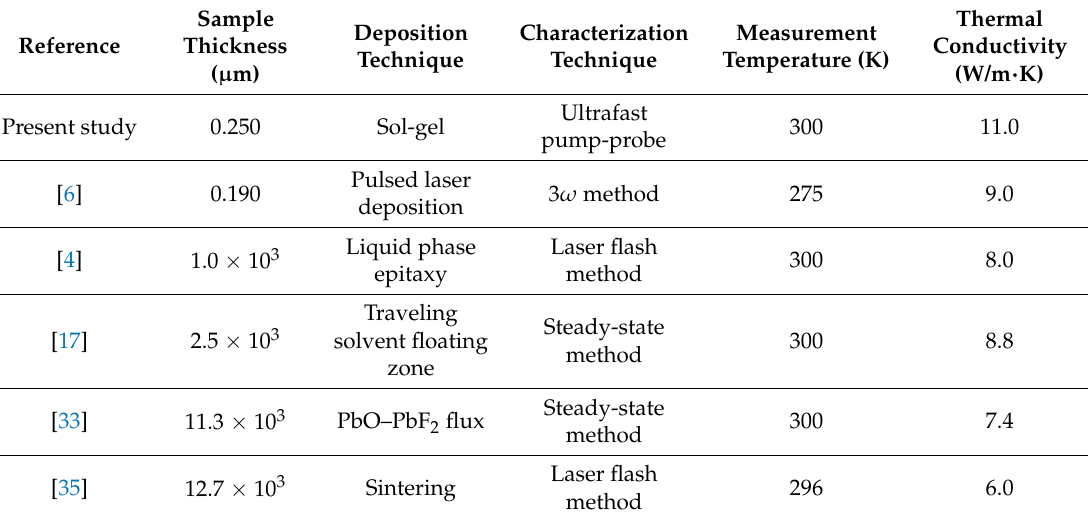
Table 3. Thermal conductivity values from